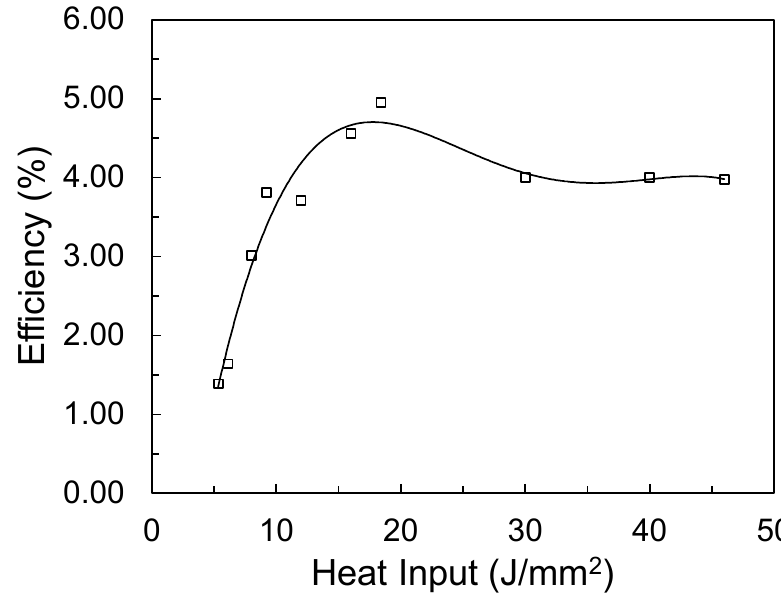
Figure 3. Graph showing a variation of hardening efficiency with heat input.